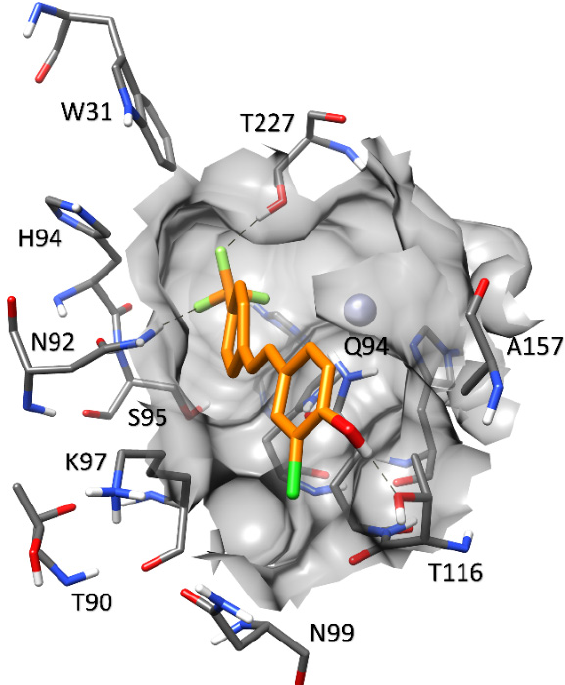
Figure 7. Predicted binding mode of compound 4 in hCA XII.